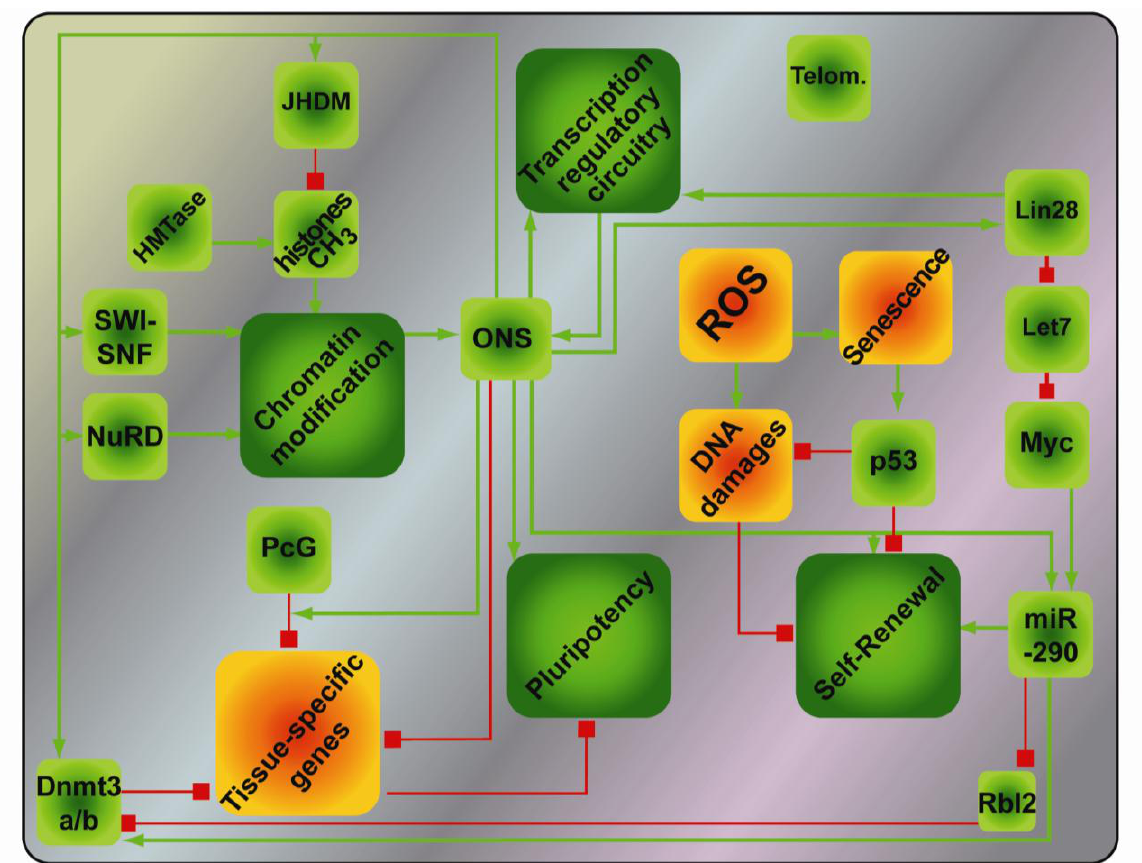
Figure 2. Interactions between the different cellular processes that regulate pluripotency. Green arrow: positive interaction, Red arrow: negative interaction. ONSK = Oct4, Nanog, Sox2; PcG = Polycomb complex; HMTase = Histone methyl transferase; ROS = radical oxygen